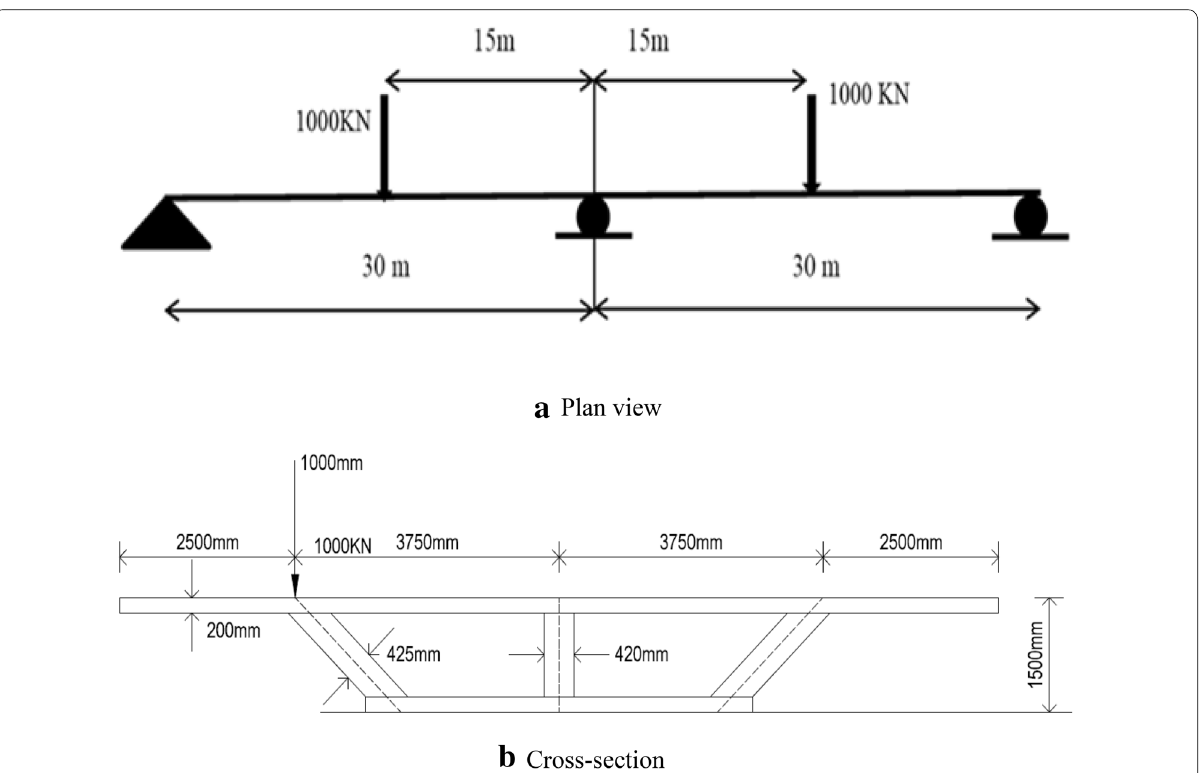
Fig. 5 Plan view and cross-section of bridge.